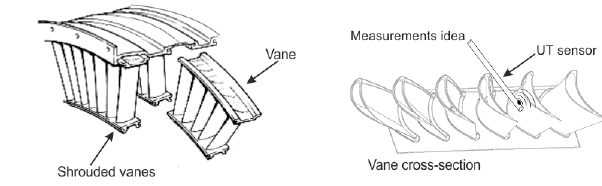
Figure 2: Layout of the coordinate systems and tools on the test stand.